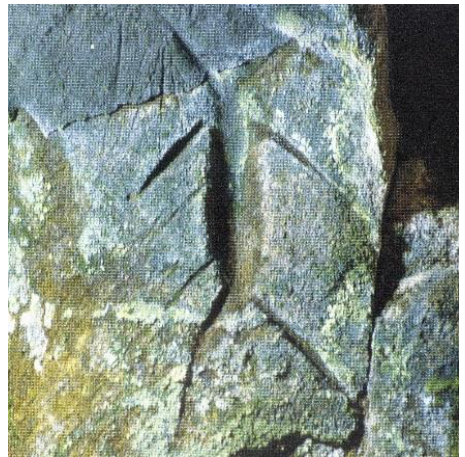
Figure 3. Abraded figure, showing red